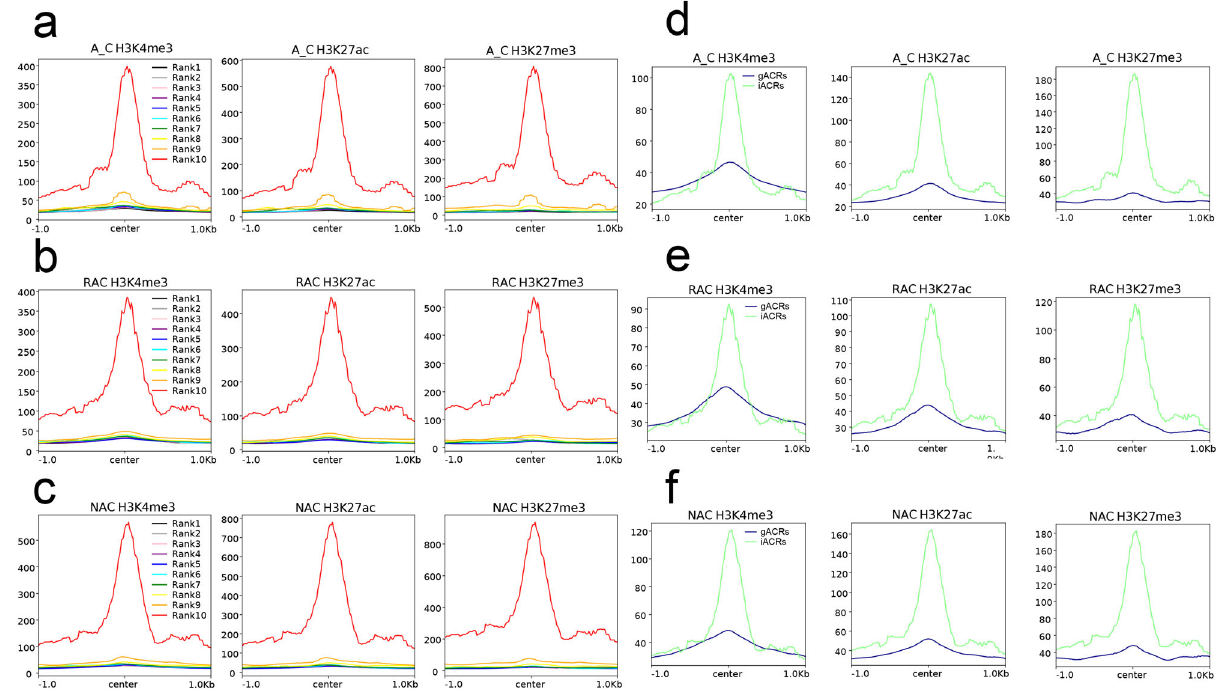
Fig. 5 Histone modi fi cations around ACRs. a H3K4me3, H3K27ac, and H3K27me3 modi fi cations around ACRs with different chromatin accessibility in A_C. b H3K4me3, H3K27ac, and H3K27me3 modi fi cations around ACRs with different chromatin accessibility in RAC. c H3K4me3, H3K27ac, and H3K27me3 modi fi cations around ACRs with different chromatin accessibility in NAC. Values of 1 to 10 denote groups with low to high chromatin accessibility, respectively. d H3K4me3, H3K27ac, and H3K27me3 modi fi cations around gACRs and iACRs in A_C. e H3K4me3, H3K27ac, and H3K27me3 modi fi cations of gACRs and iACRs in RAC. f H3K4me3, H3K27ac, and H3K27me3 modi fi cations of gACRs and iACRs in NAC. A_C, in silico ‘ hybrid ’ ; RAC, resynthesized B. napus ; NAC, natural B. napus ; ACRs, accessible chromatin regions; gACRs, genic ACRs; iACRs, intergenic ACRs; center, peak center of